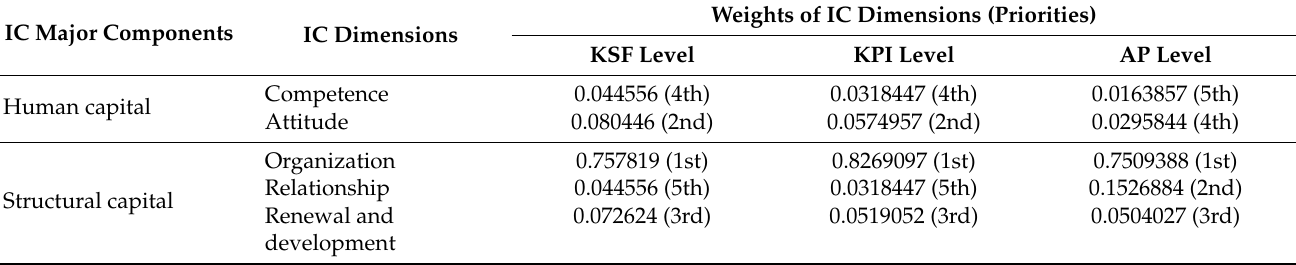
Table 8. Weights of IC dimensions in different